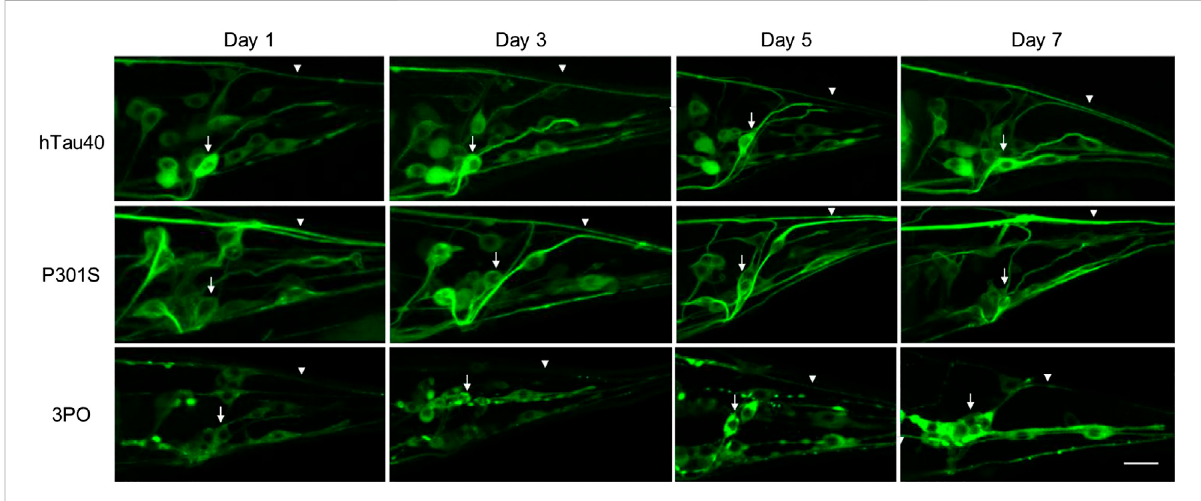
FIGURE 2 Age-dependent accumulation of tauGFP. We monitored TauGFP during aging in the animals. Across the fi rst 7 days of adulthood, hTau40GFP was observed in cell bodies (arrows) and in axonal processes (arrowheads) consistently across aging. Compared to the wild-type we noticed that P301SGFP appears to be enriched in the axons (arrowheads), with a decrease in cell body fl uorescence (arrows) during aging. 3POGFP was preferentially accumulated in cell bodies (arrows), with less fl uorescence present in nerve processes (arrowheads). In addition, tau in the cell bodies in animals expressing 3POGFP appeared to be more clustered than those in animals expressing wild-type or P301S tau. Scale bar equals 10 μ m.